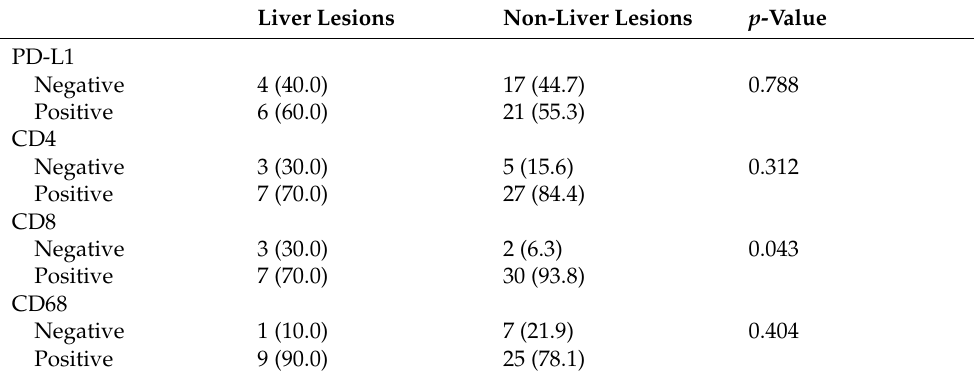
Table 3. PD-L1, CD4, CD8, CD68 expression of liver and non-liver lesions in NSCLC patients with liver